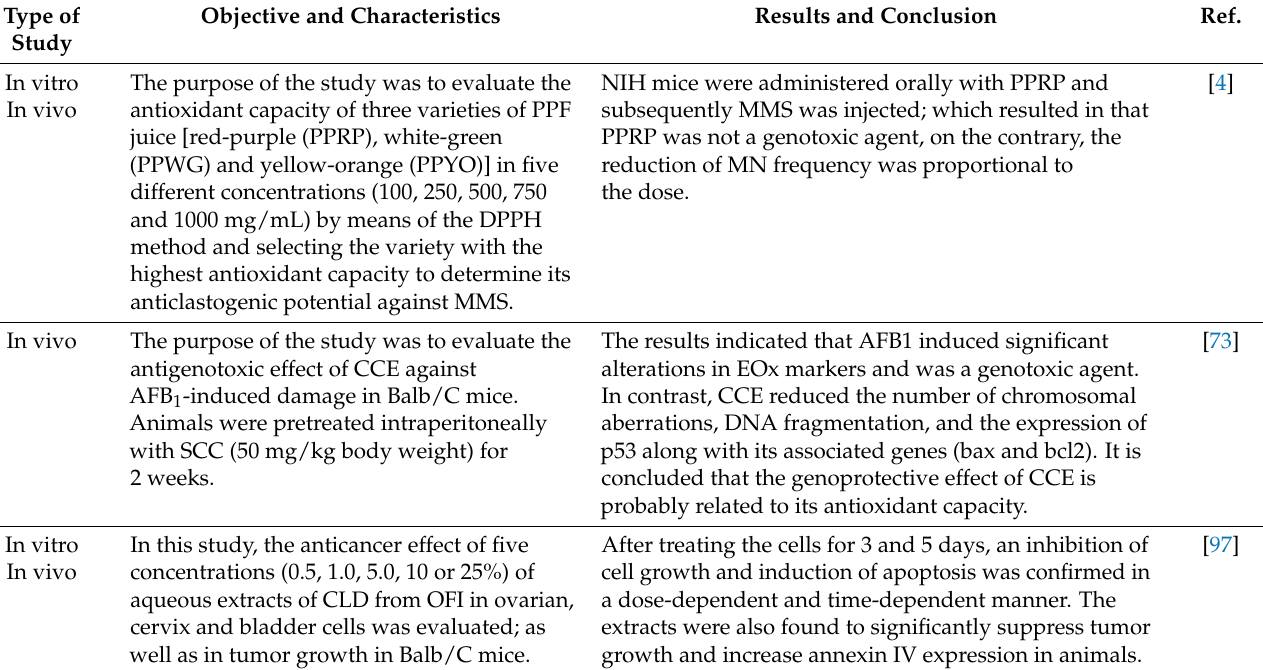
Table 4. Main studies of Opuntia spp. on its chemopreventive and antigenotoxic